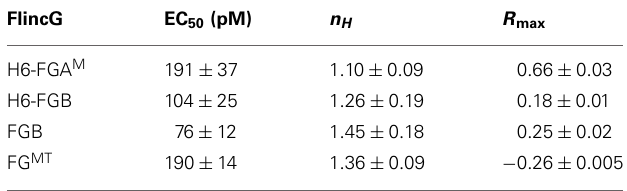
Table 1 | Concentration-response curve parameters for purified FlincG proteins.